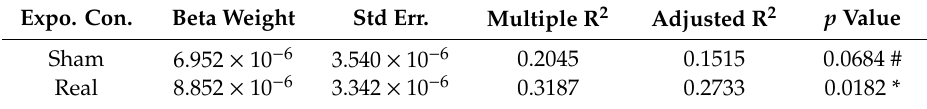
Table 3. Regression findings for the results of RT assessment with simultaneous beta PSD data under di ff erent exposure conditions, where “Expo. Con.” refers to “Exposure Conditions”, and “Std Err.” refers to “Standard Errors”. Expo. Con. Beta